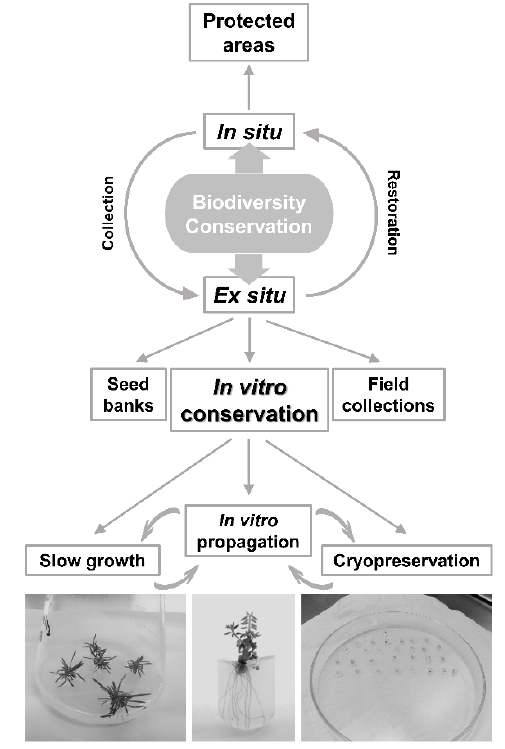
Figure 1. Schematic representation of different conservation strategies with focus on biotechnological-based techniques (adapted from [18]).